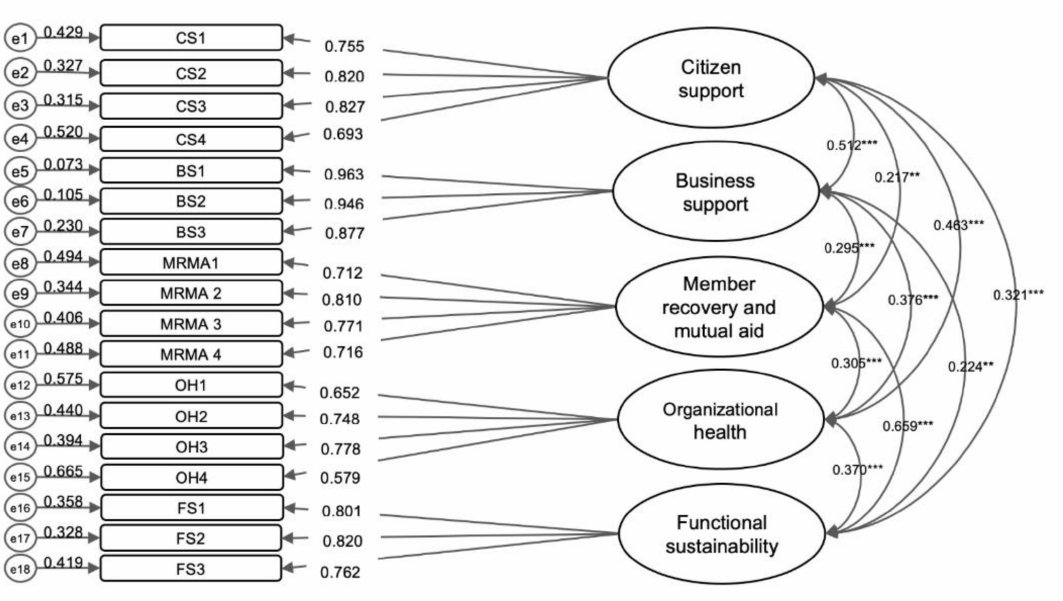
Figure 1. Factor Structure of the SHODS, ** p < 0.01, *** p <